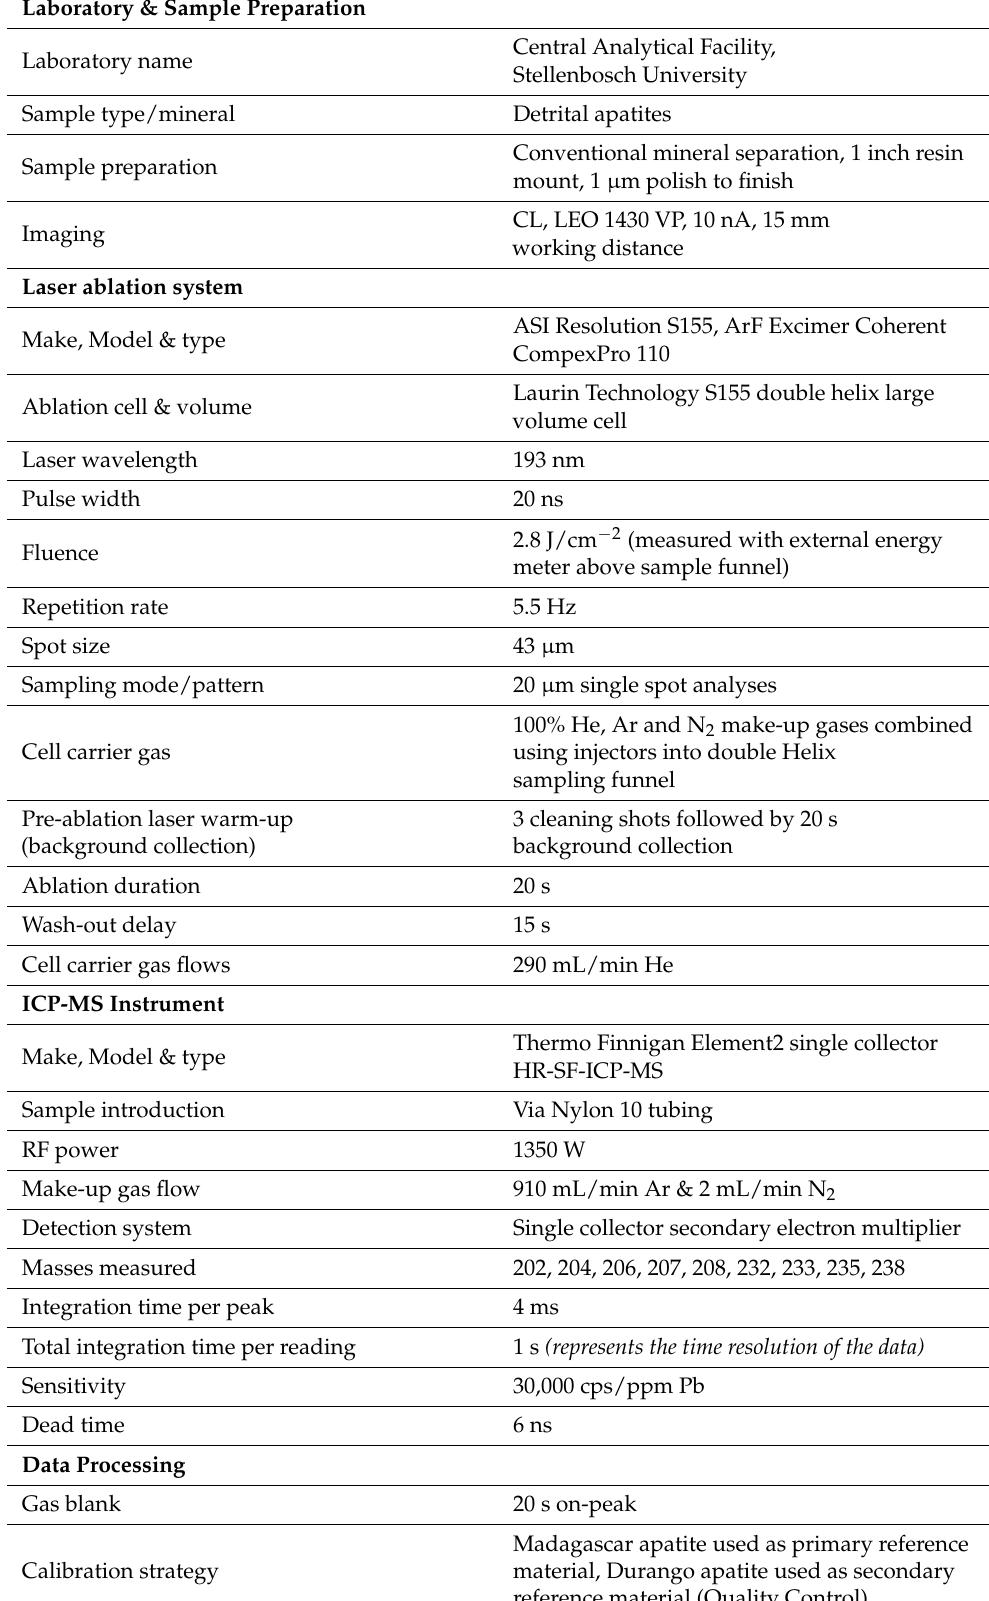
Table 2. LA-SF-ICP-MS U-Pb dating methodology for apatites discussed in this